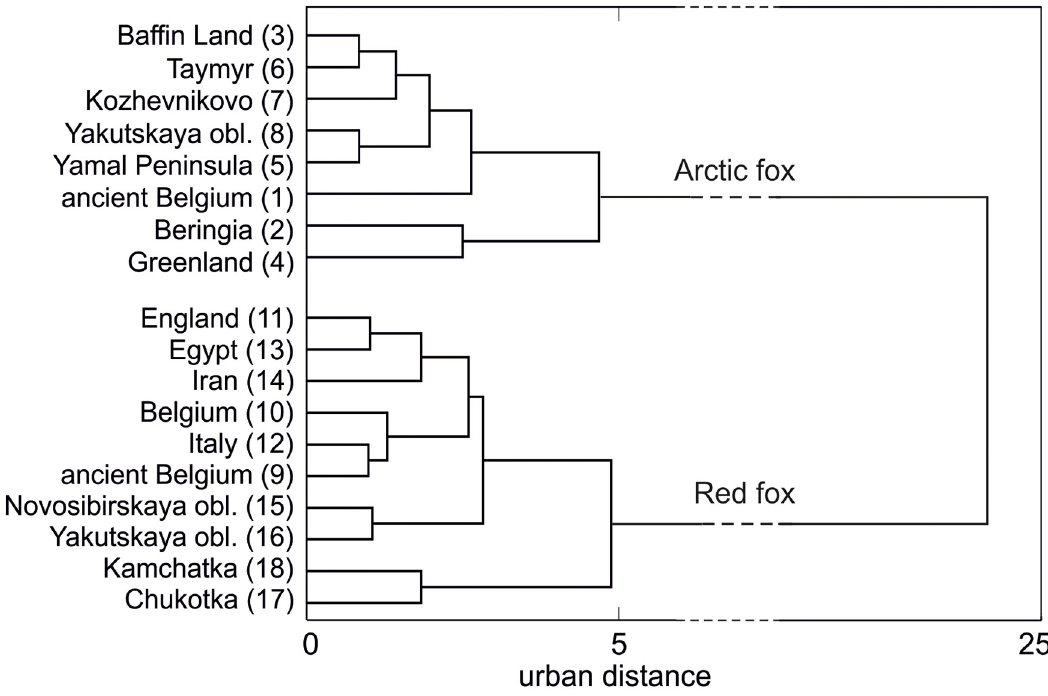
Fig 14. Agglomeration of the recent and fossil populations of the arctic and red foxes constructed by the Ward method and Manhattan distances using the percentage shares of the morphotypes of the first lower molar.